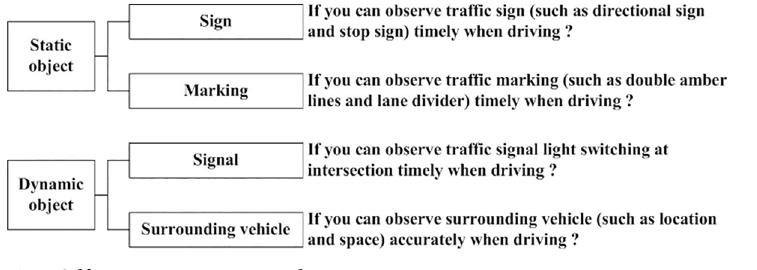
Fig 1. Self-assessment structure and